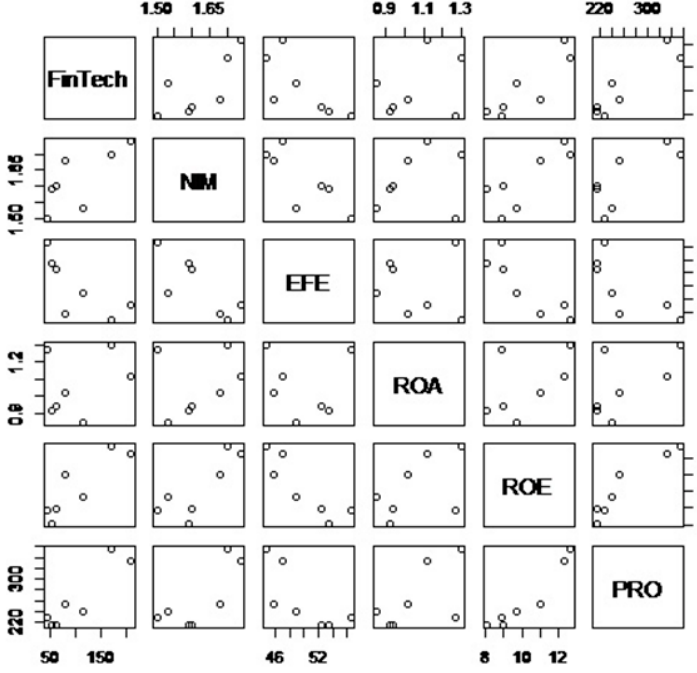
Figure 7. Dispersion diagram of variables.